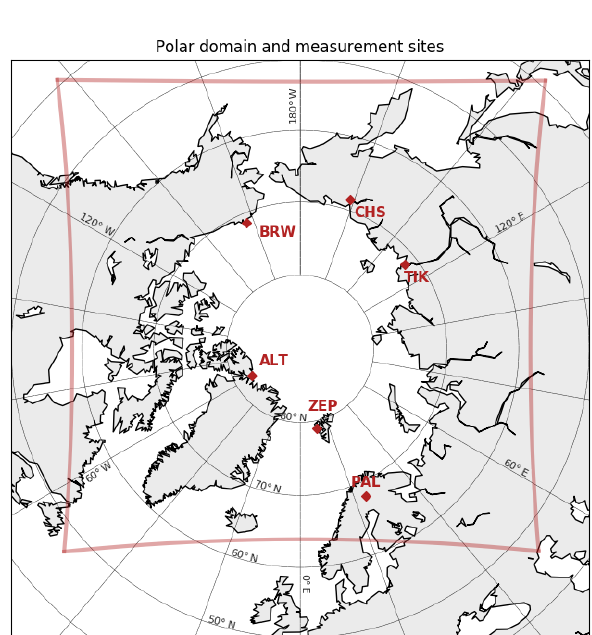
Figure 1. Delimitation of the studied Polar domain and location of the six continuous measurement sites used in this study. ALT: Alert. BRW: Barrow. CHS: Cherskii. PAL: Pallas. TIK: Tiksi. ZEP: